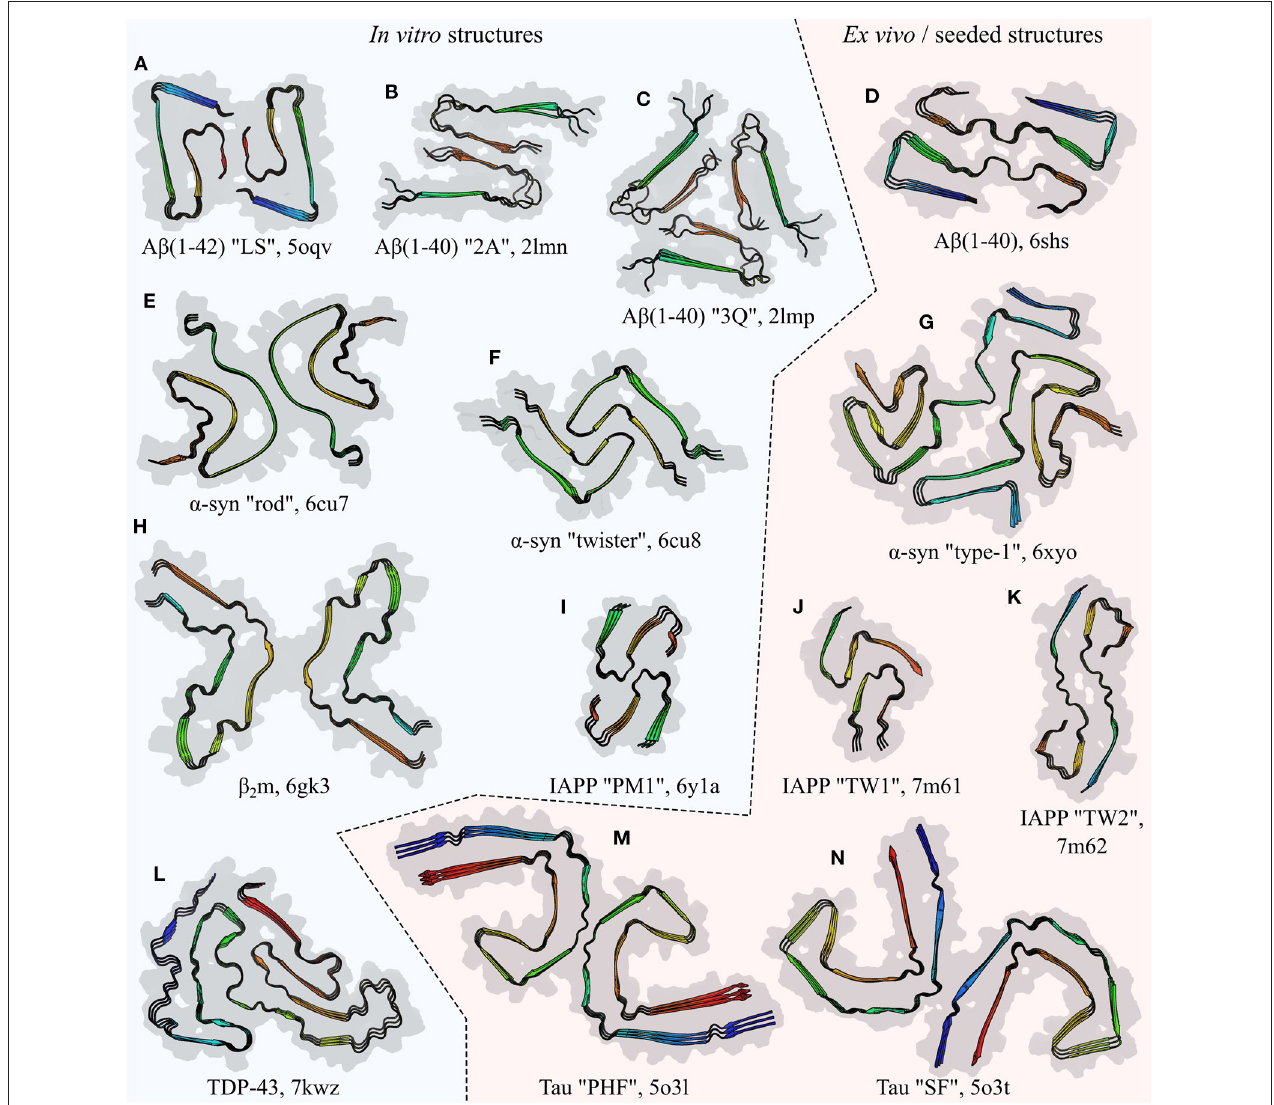
FIGURE 5 | Comparison of the folds of amyloid fibril subunits, illustrated by examples from six polypeptides: amyloid- β (A β ; Paravastu et al., 2008; Gremer et al., 2017; Kollmer et al., 2019), α -synuclein ( α -syn; Li et al., 2018a; Schweighauser et al., 2020), β 2 -microglobulin ( β 2 m; Iadanza et al., 2018b), islet amyloid polypeptide (IAPP; Röder et al., 2020; Cao et al., 2021), TDP-43 (Li et al., 2021), and Tau (Fitzpatrick et al., 2017). The name of the polypeptide is given below each structure, alongside the polymorph in quotes where relevant, and the PDB ID. Each structure is a stack of three subunit layers, viewed from a perspective facing down the fibril axis and using the same scale for all panels. Structures are composites of the surface (gray) and ribbon diagram (colored) representations, with the color of the latter varying spectrally from the N-terminus (blue) to the C-terminus (red); the true termini are used for spectral coloring of (A–K) , whereas the ends of the structured segments are used for (L–N) . Unstructured segments are not shown. Fibrils produced entirely in vitro are shown on the left of the central dashed line, while those extracted (D,G,M,N) or seeded (J,K) from living tissue are shown on the